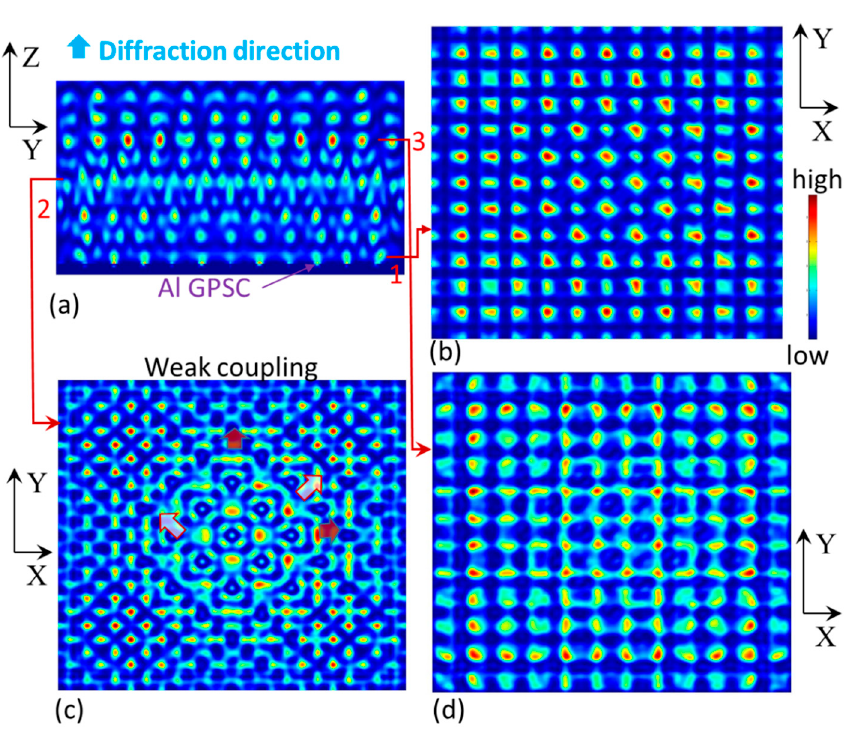
Figure 4. ( a ) E-field intensity in a cross section in yz plane. ( b – d ) E-field intensity in a cross section in xy plane through z-location at 1, 2, and 3 labeled in ( a ), respectively.